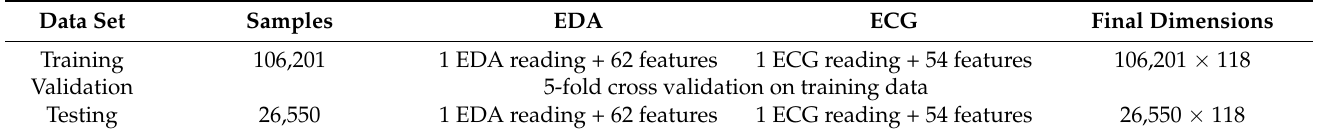
Table 1. Summary of Data Sets.